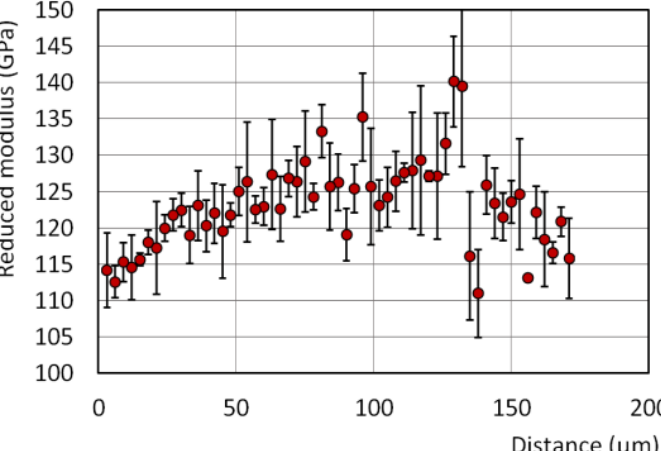
Figure 6. Reduced modulus vs. the distance from the longitudinal symmetry axis of the initial wire: nanoindentation test result.